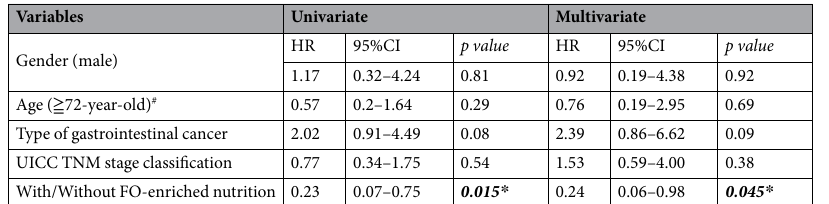
Table 4. Multivariate analysis to identify predictors of overall survival in GI cancer patients with an mGPS of 1 or 2. # The median age at treatment was 72 years in this cohort. HR: Hazard ratio. * p < 0.05